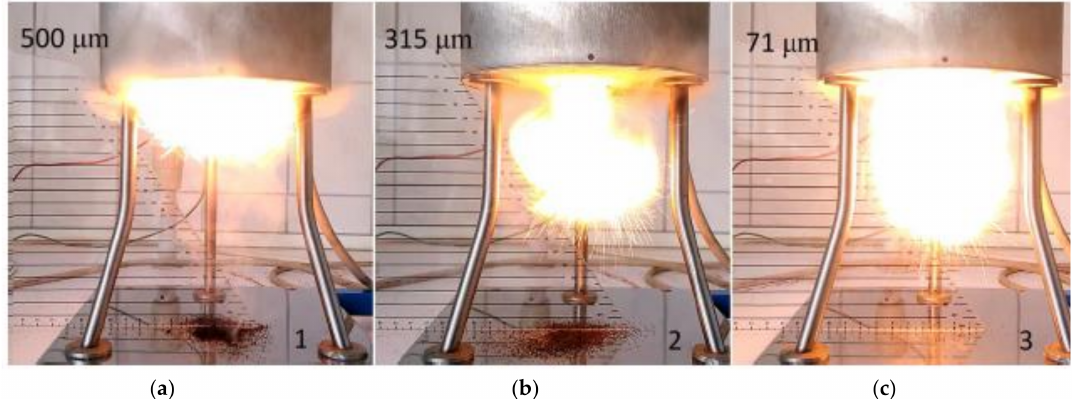
Figure 8. The flame on ignition (conditions: 0.2 g of dust, air pressure of 30 kPa, the temperature of the ceramic tube furnace 500 ◦ C). Images were prepared using a Basler a602fc-2 high-speed camera (Basler AG, Ahrensburg, Germany). Legend: ( a ) Point of ignition for fraction 500 µ m of ebony dust; ( b ) point of ignition for fraction 315 µ m of ebony dust; ( c ) point of ignition for fraction 71 µ m of ebony